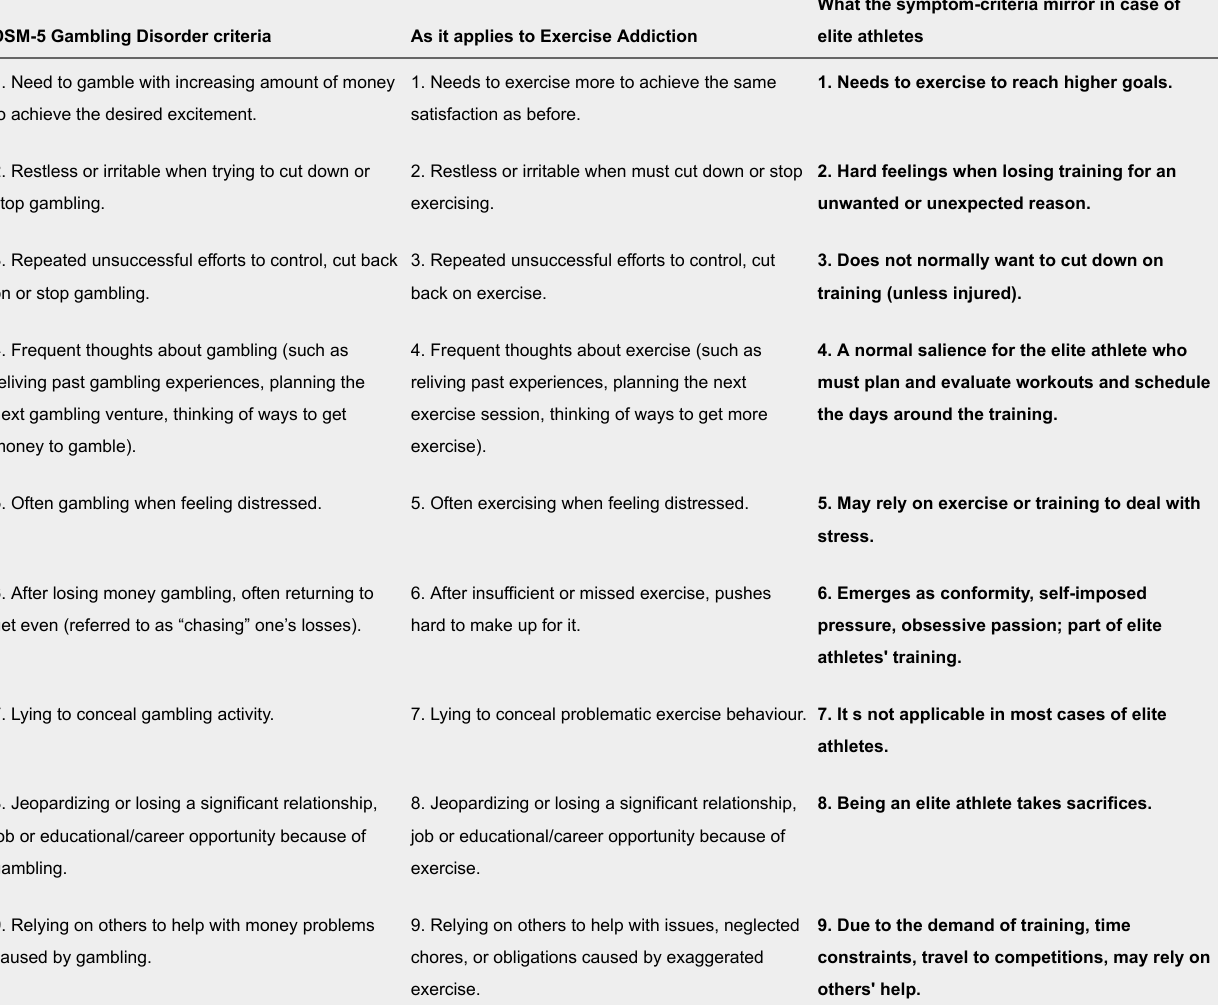
DSM-5 Gambling Disorder